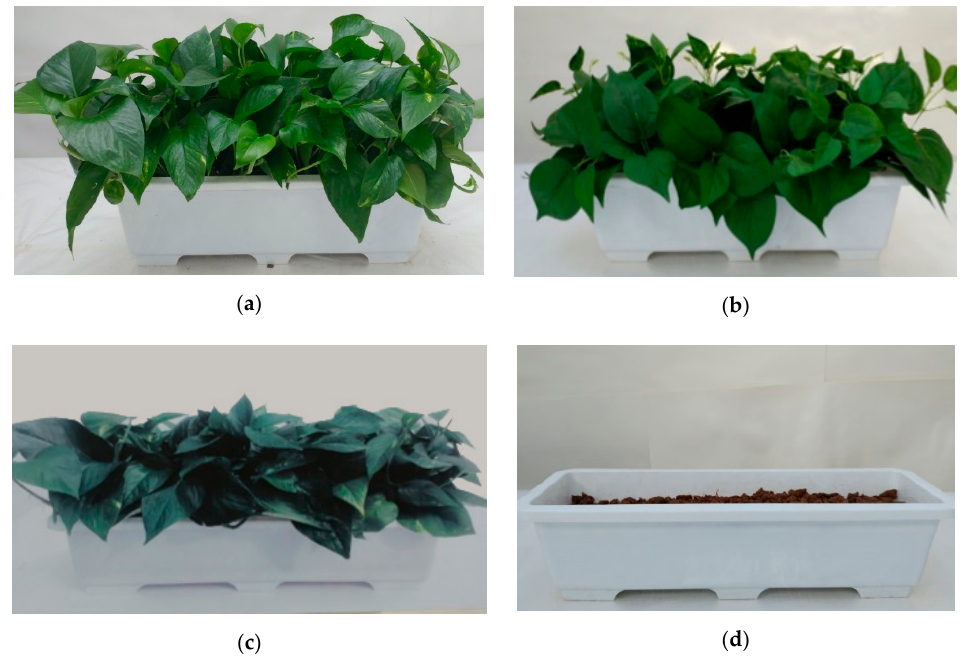
Figure 2. Experimental materials and set-ups used as the visual stimuli: ( a ) Actual plants, ( b ) Artificial plants, ( c ) Photograph of plants, and ( d ) Absence of plants.